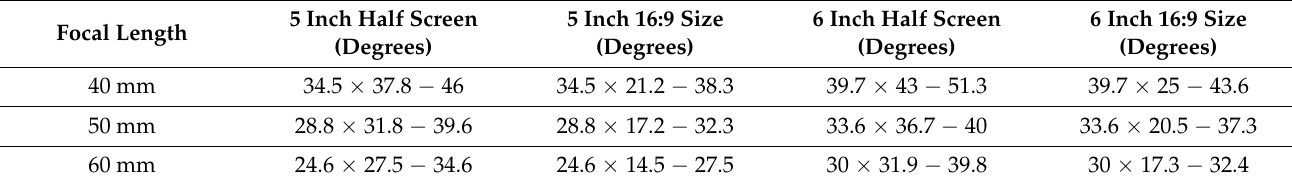
Table 3. Half-field angle of different focal lengths and screens.